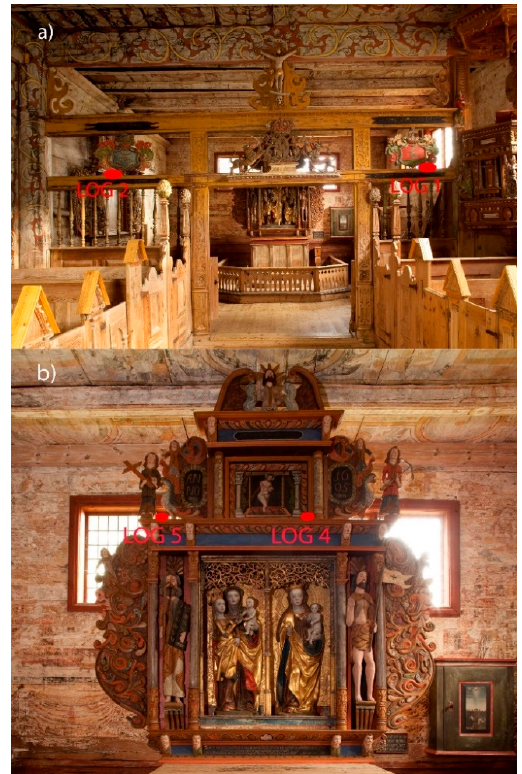
Figure 7. Images showing the location of the four data loggers in Kvernes stave church. ( a ) loggers 1 and 2; ( b ) loggers 4 and 5 (date: 3 March 2011) Photo: NIKU ©